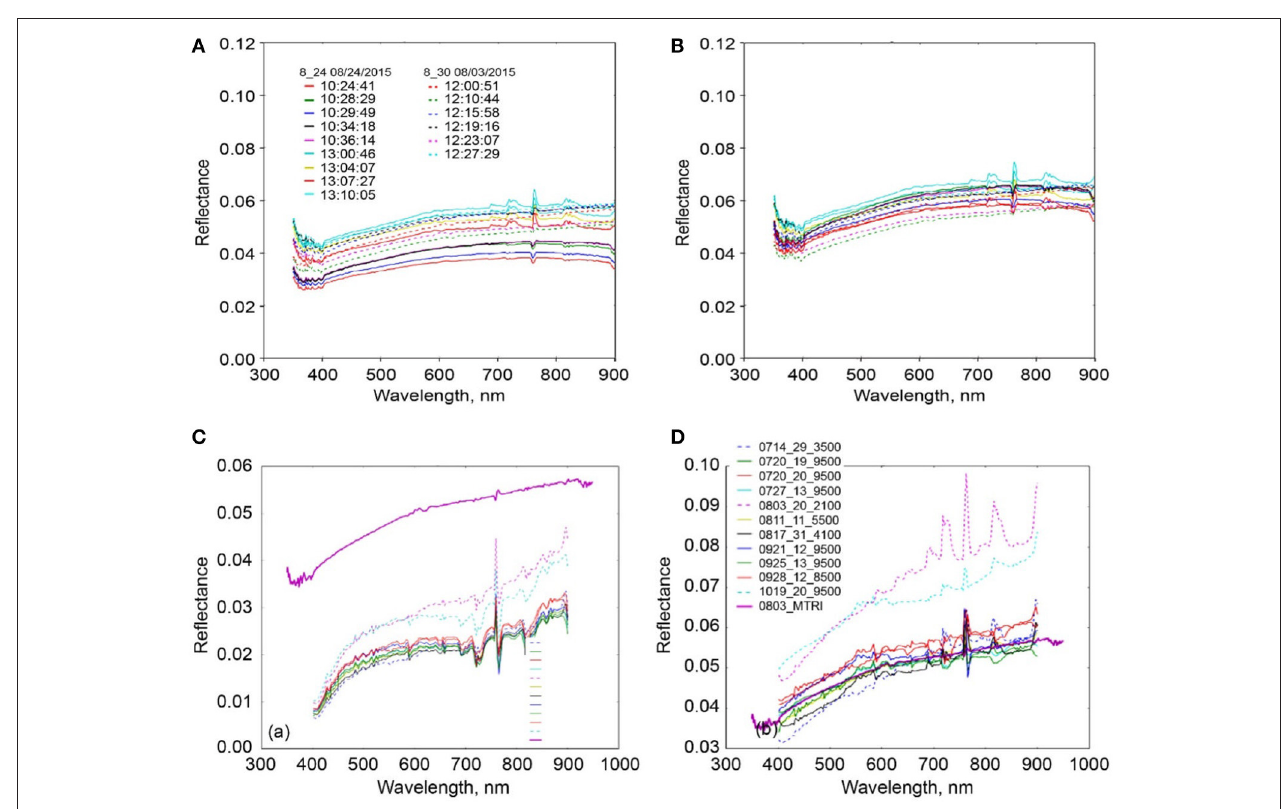
FIGURE 6 | (A) Maumee Bay State Park (MBSP) in situ reflectance before time correction. (B) MBSP in situ reflectance after time correction. (C) NASA Glenn, second generation Hyperspectral imager (HSI2) parking lot reflectance uncorrected. (D) NASA HSI2 parking lot reflectance corrected. In situ reflectance is shown in magenta (labeled 0803_MTRI) in (C,D) (After Figures 4.4 and 4.6, Lekki et al.,